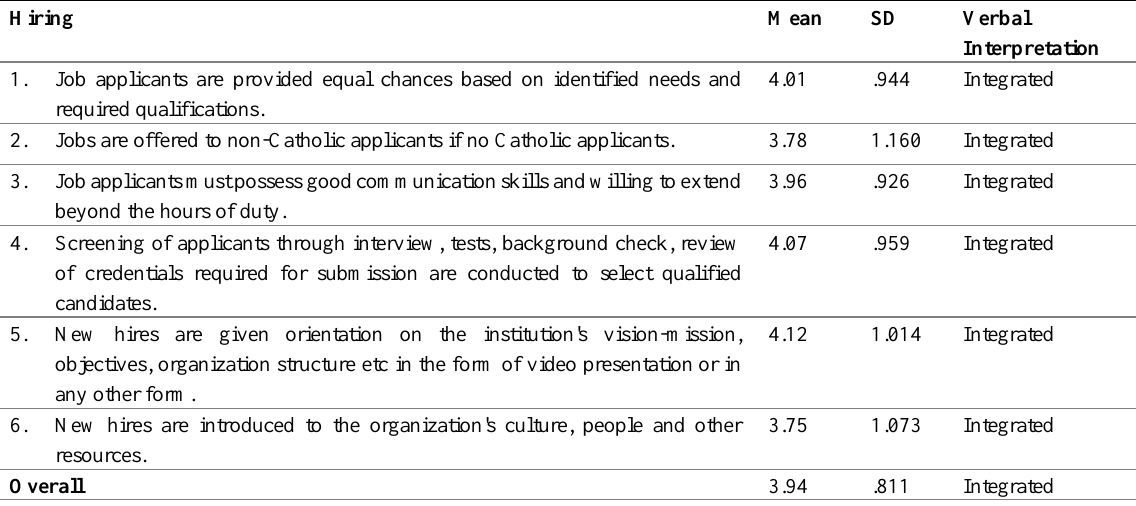
Table 1: Extent of Integration of Integrity to Hiring as Perceived by Respondents